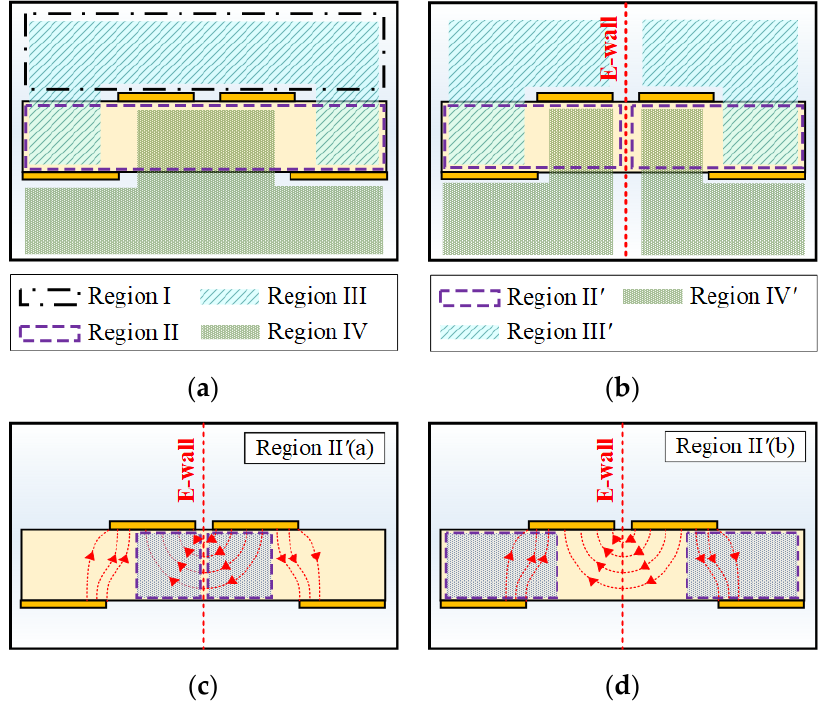
Figure 11. Cross-sectional model of the DL-to-CPS transition: ( a ) four analysis regions, ( b ) analysis regions divided by an E-wall, located in the middle of the transition, ( c ) Region II ′ (a) between the signal line and the E-wall, and ( d ) Region II ′ (b) between the signal line and the ground line. Region I: Upper Region of the Transition